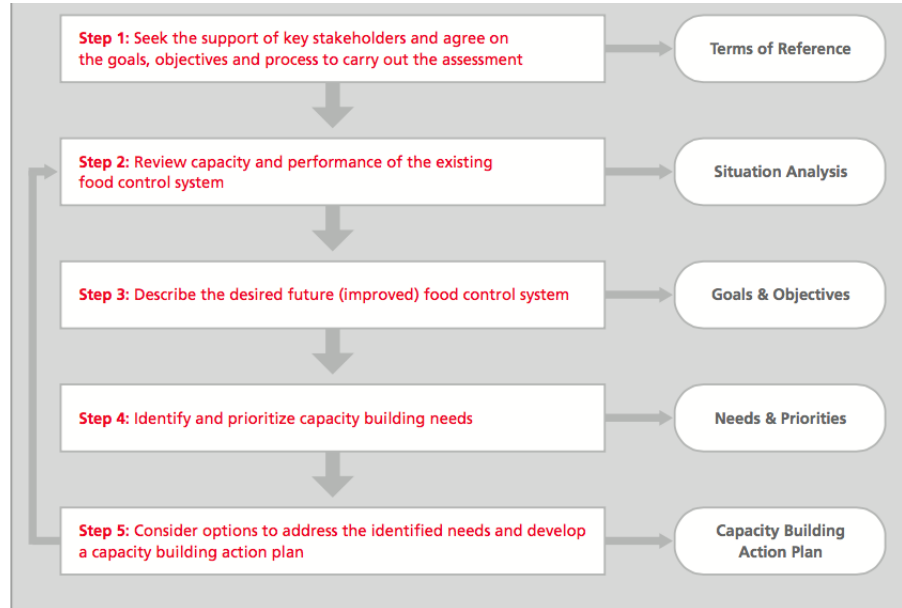
Figure 2. The FAO’s process for assessing needs and building capacity.